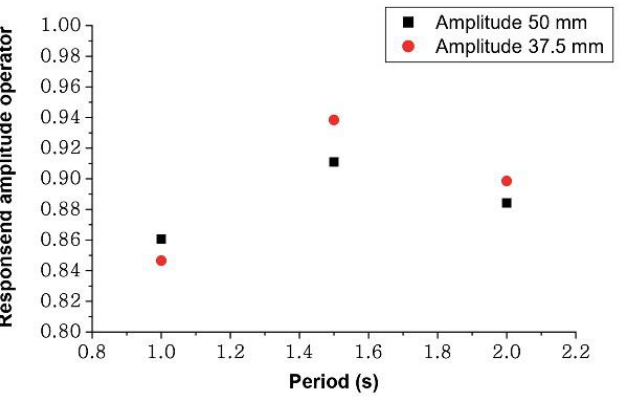
Figure 13. The response amplitude operator (RAO) of the buoy.